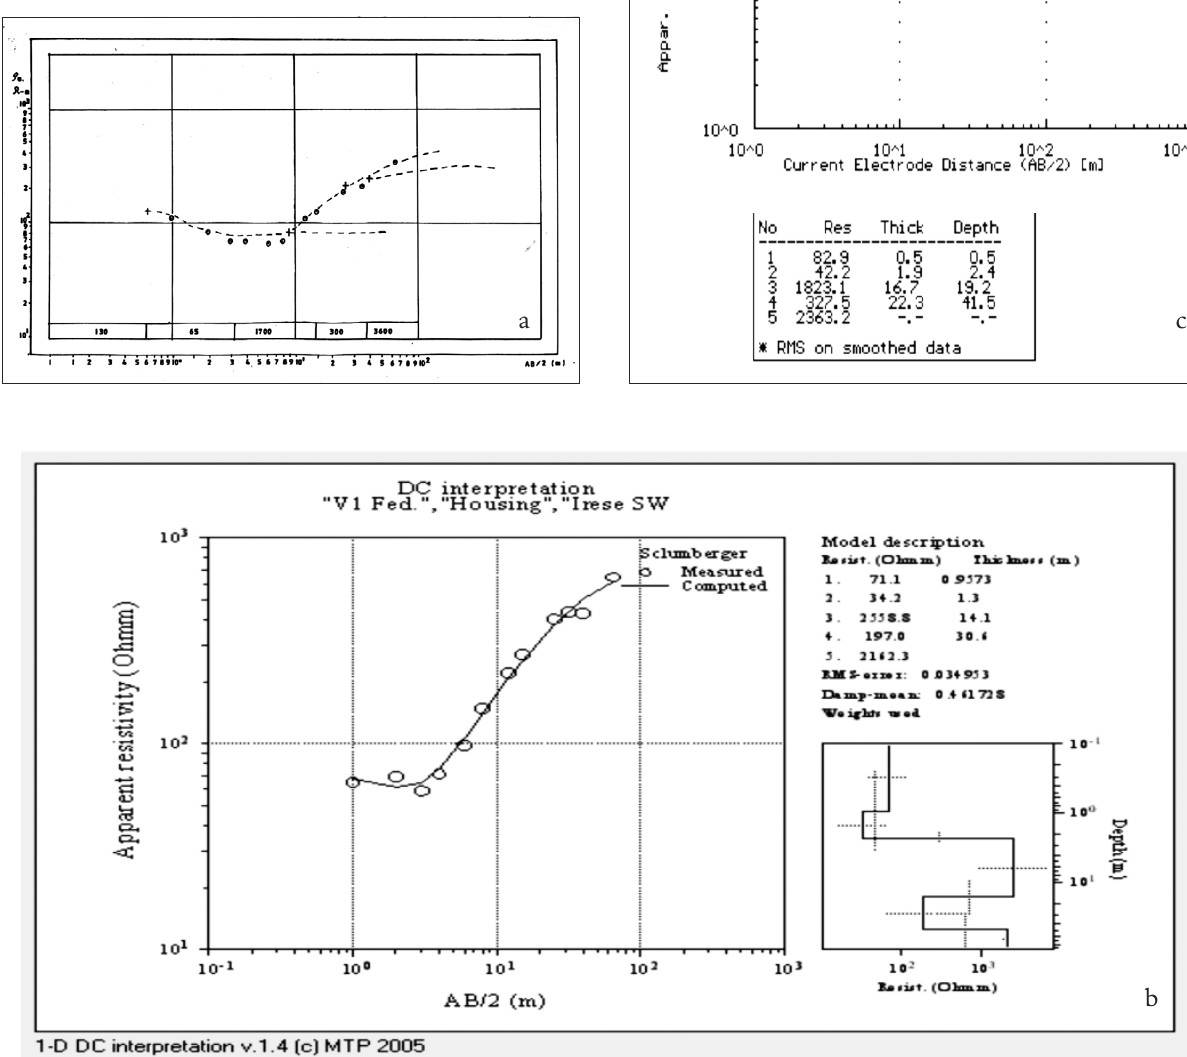
Figure 5. Manual and iterated VES curve at V1 in Irese area, Akure, SW